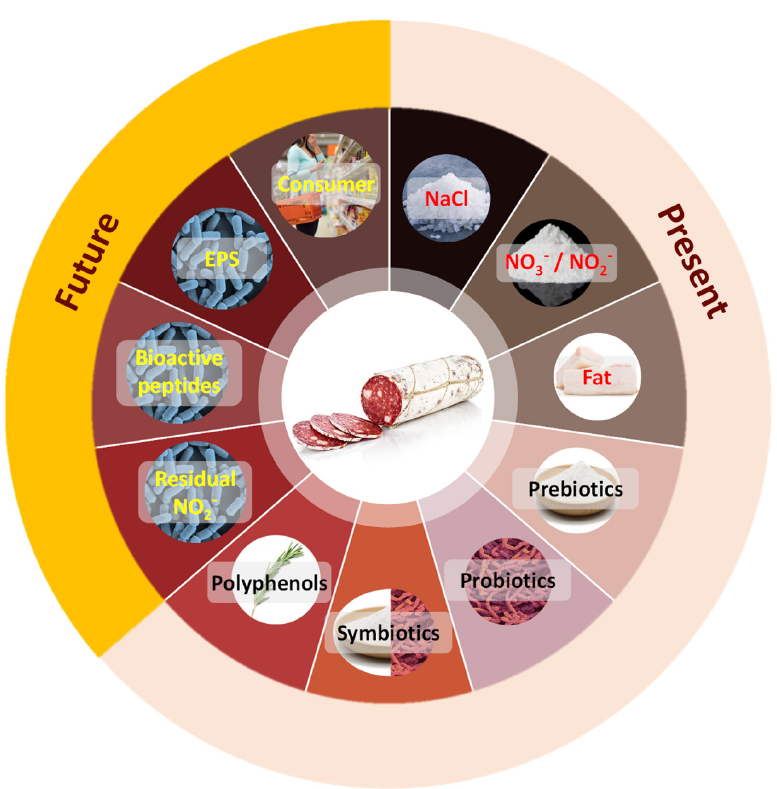
Figure 1. Main factors in the development of healthier and functional fermented meat products.